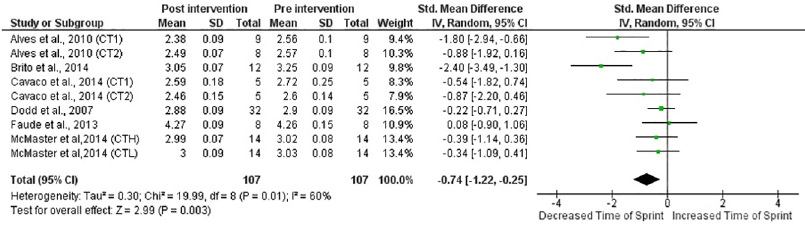
Fig 2. Standardized mean difference (SMD) between post and pre-intervention sprint time in CT- trained subjects. Squares representthe SMD a for each trial. Diamonds represent the pooledSMD across trials.